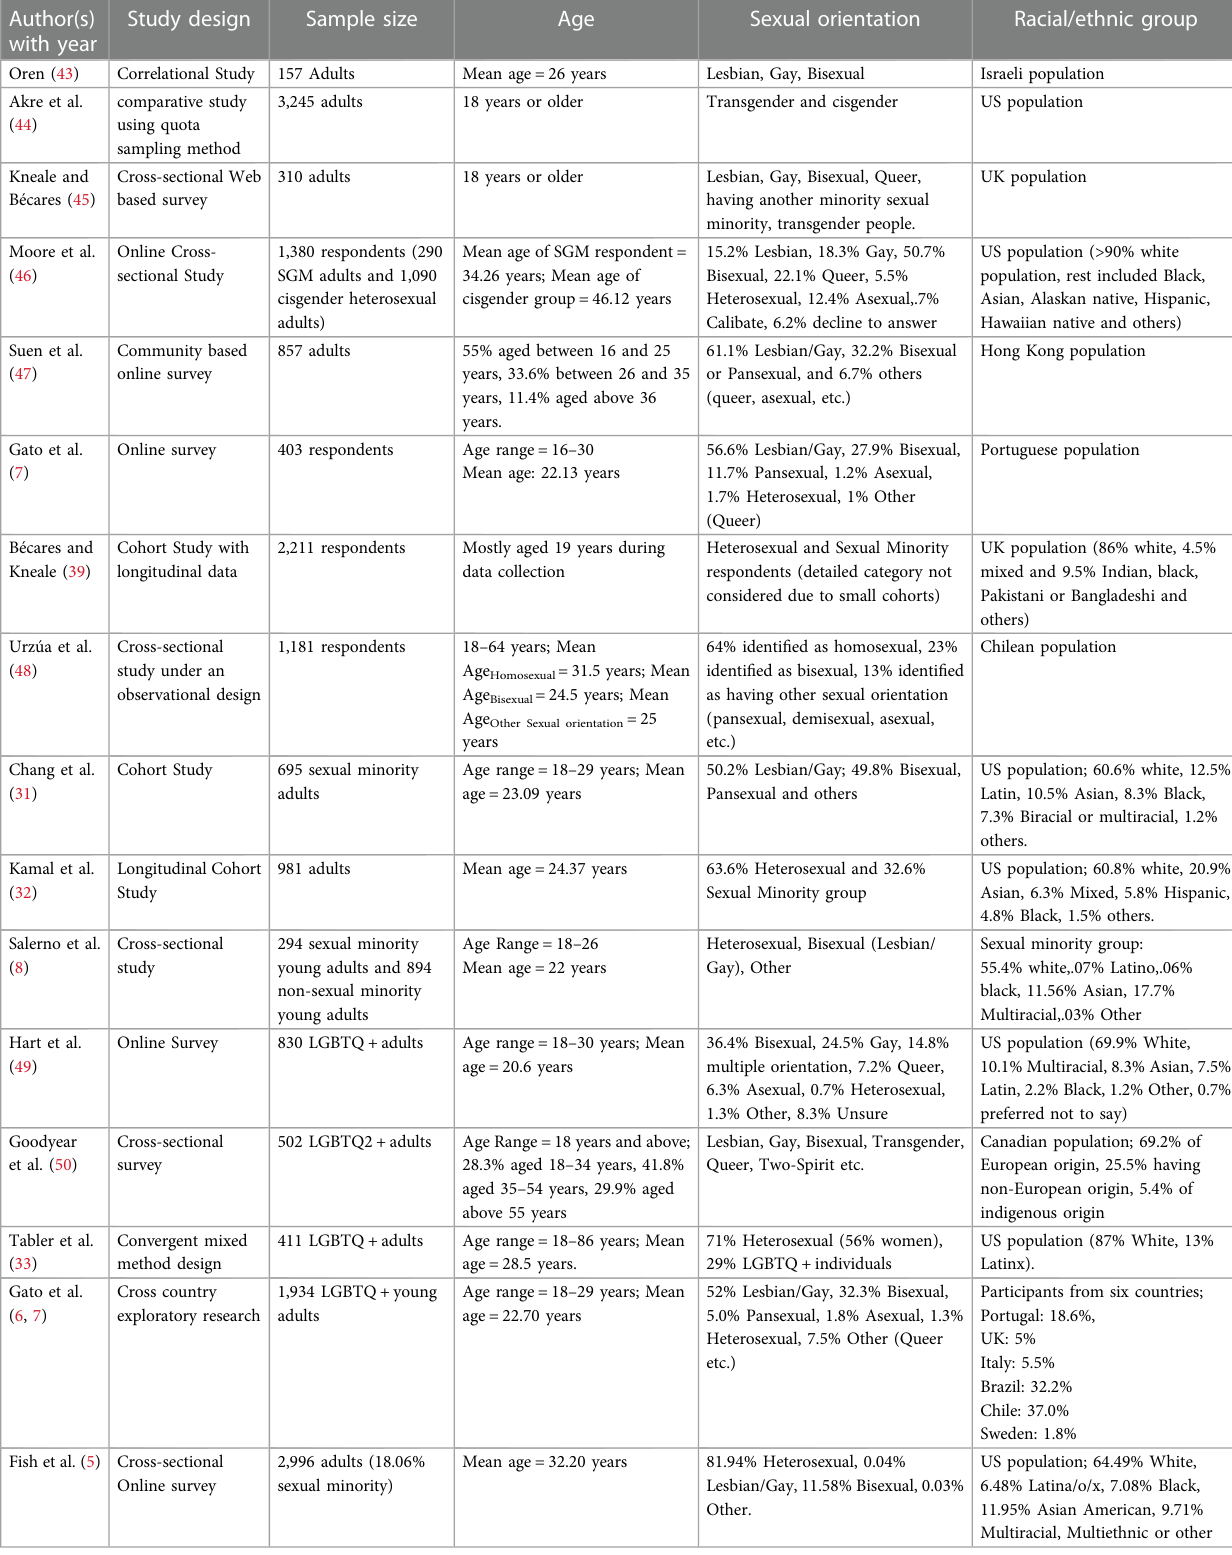
TABLE 1 Comparative view of the study characteristics and demographics of the study participants.